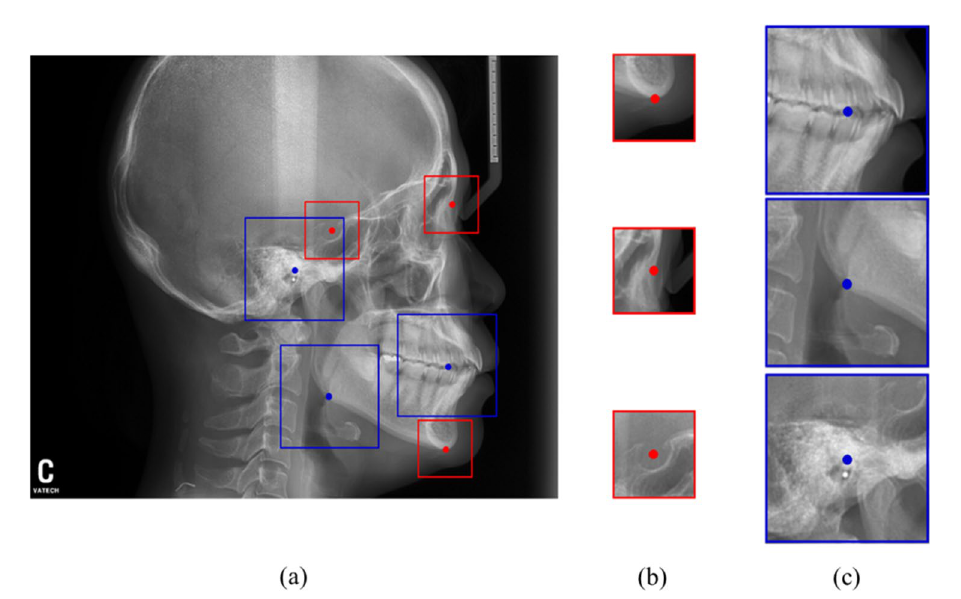
Figure 3. Two sizes of ROIs in the cephalometric X-ray. ( a ) ROIs with 256 × 256 and 512 × 512 size were extracted by landmarks. ( b ) Sella, nasion, and menton requiring a small ROI with 256 × 256 size (red), and ( c ) hinge, corpus and Md6 root requiring a wide ROI with 512 × 512 size